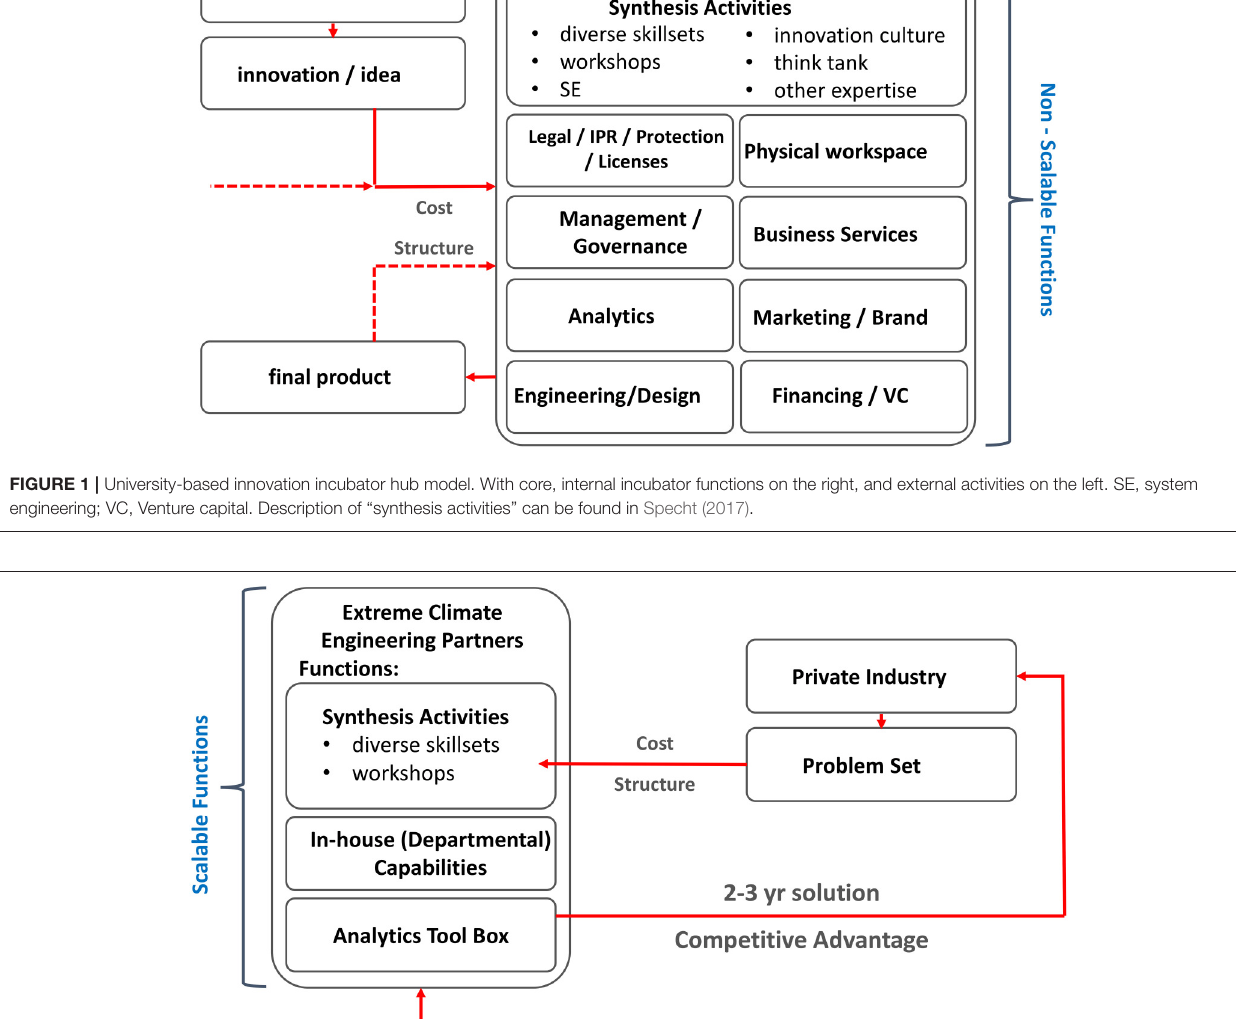
Frontiers in Environmental Science |